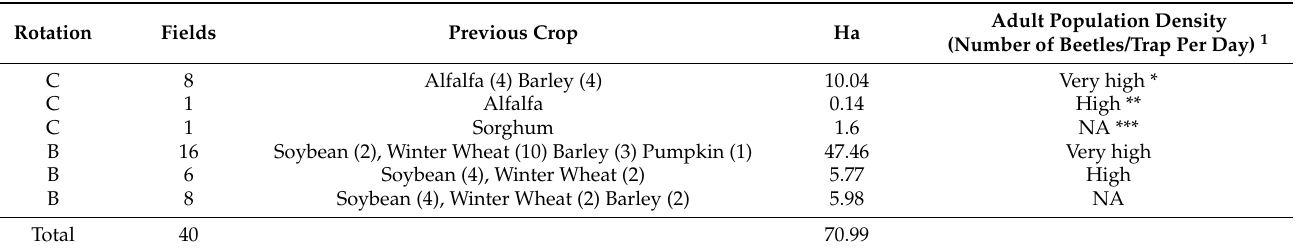
Table 5. Maize fields following no maize crop in the previous year, damaged (>5% of goosenecked or lodged plants) by WCR larvae from 2014 to 2017 in